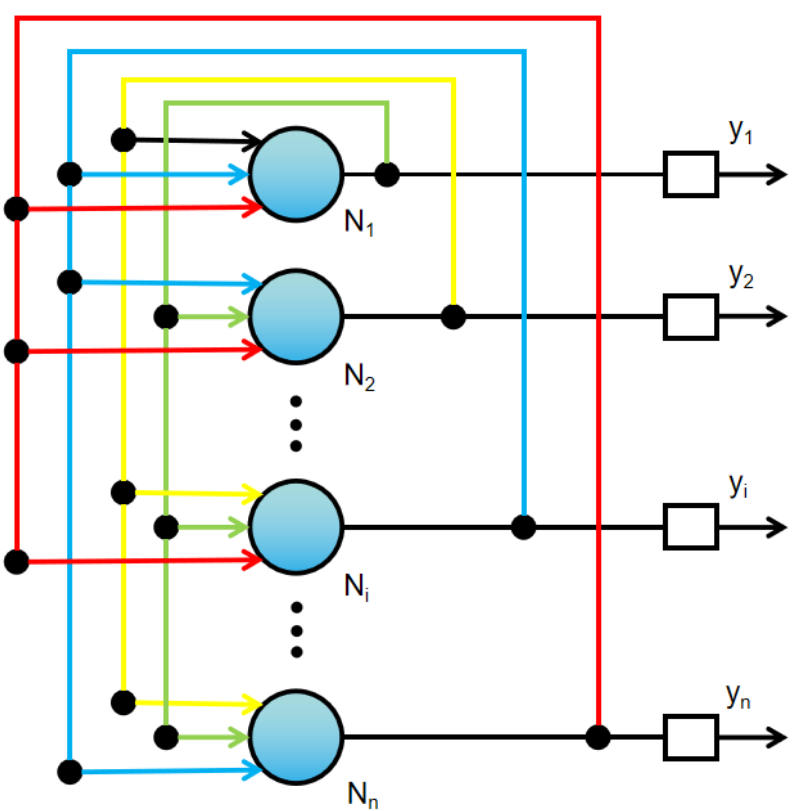
Figure 2. Discrete Hopfield neural network